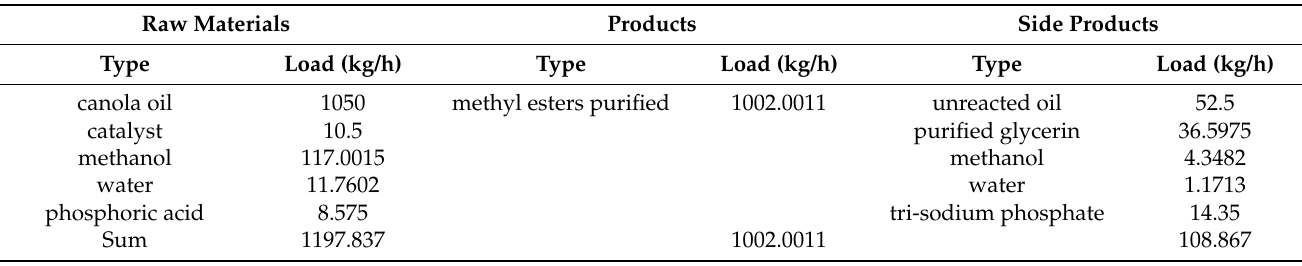
Table 10. Material balance of raw materials, products, and by-products after taking into account all four stages of the technological process.